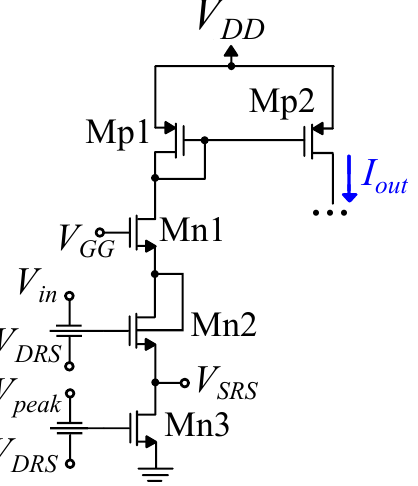
Figure 20. A floating gate transistor based modification of a bump–antibump circuit.